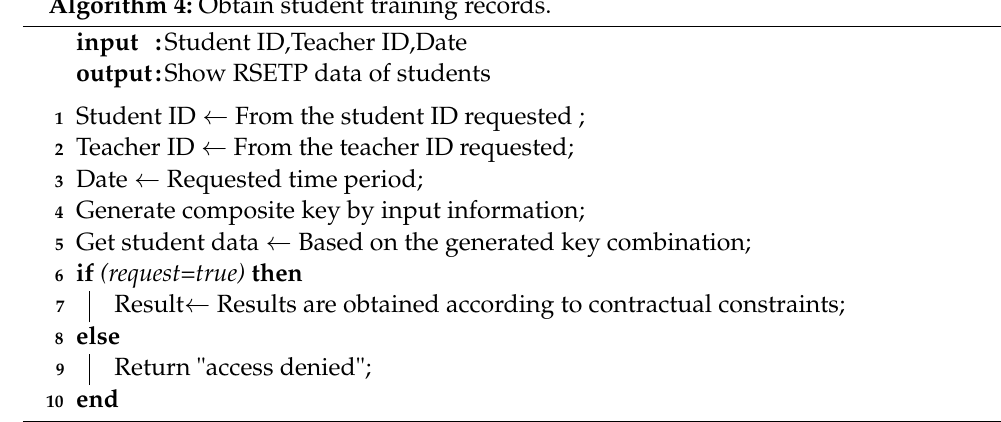
Algorithm 4: Obtain student training